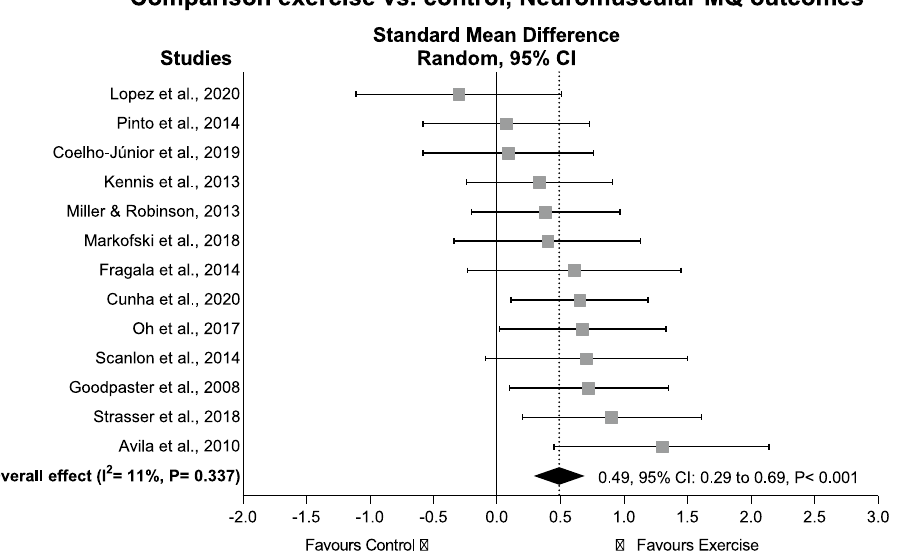
Figure 3. Standardised mean difference effects of exercise compared with control on neuromuscular muscle quality outcomes in older adults. Overall analysis conducted with a random-effects model. Diamond represents pooled standardised mean difference estimate of random-effects meta-analysis; I 2 represents the heterogeneity test; MQ , muscle quality; squares represent study-specific